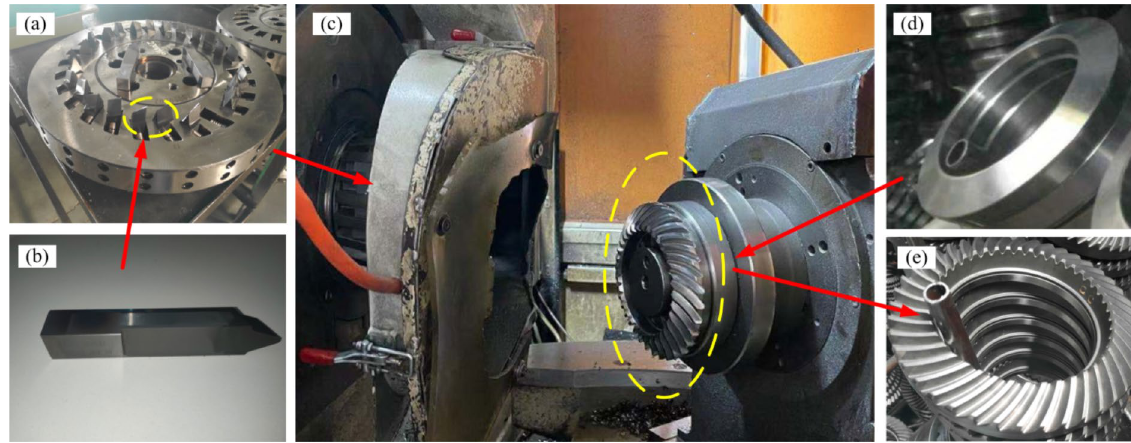
Figure 3 Dry milling machine device for contour bevel